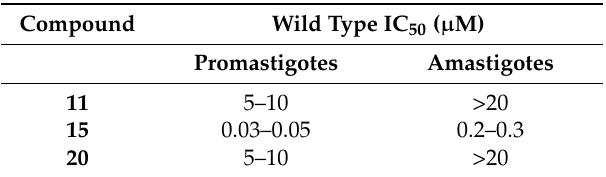
Provided intervals are results of three independent